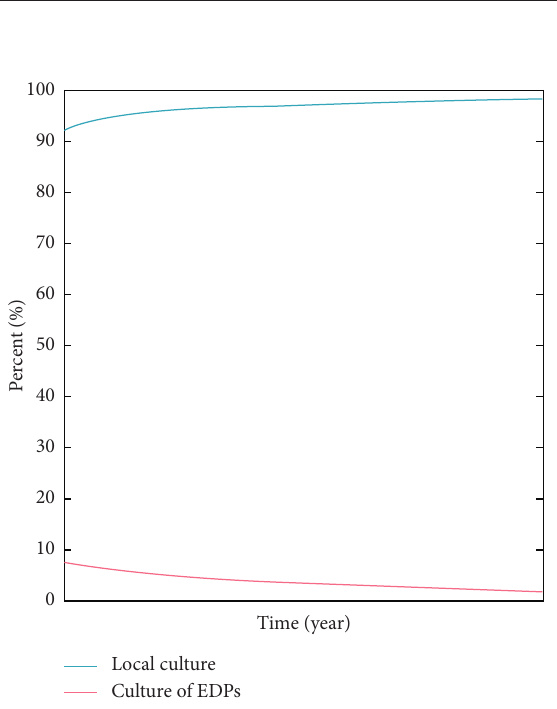
Figure 5: Population of culture over time without interference.